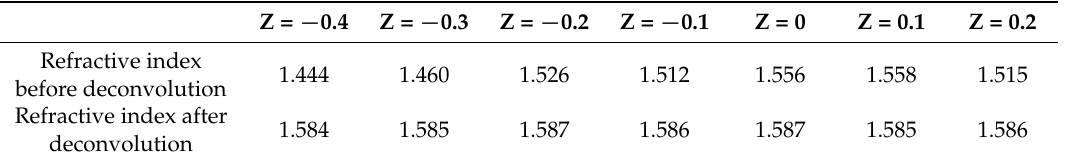
Table 1. Mean values of the refractive index of the microsphere at the wavelength 640 nm for each plane Z (µm ). Z = − 0.4